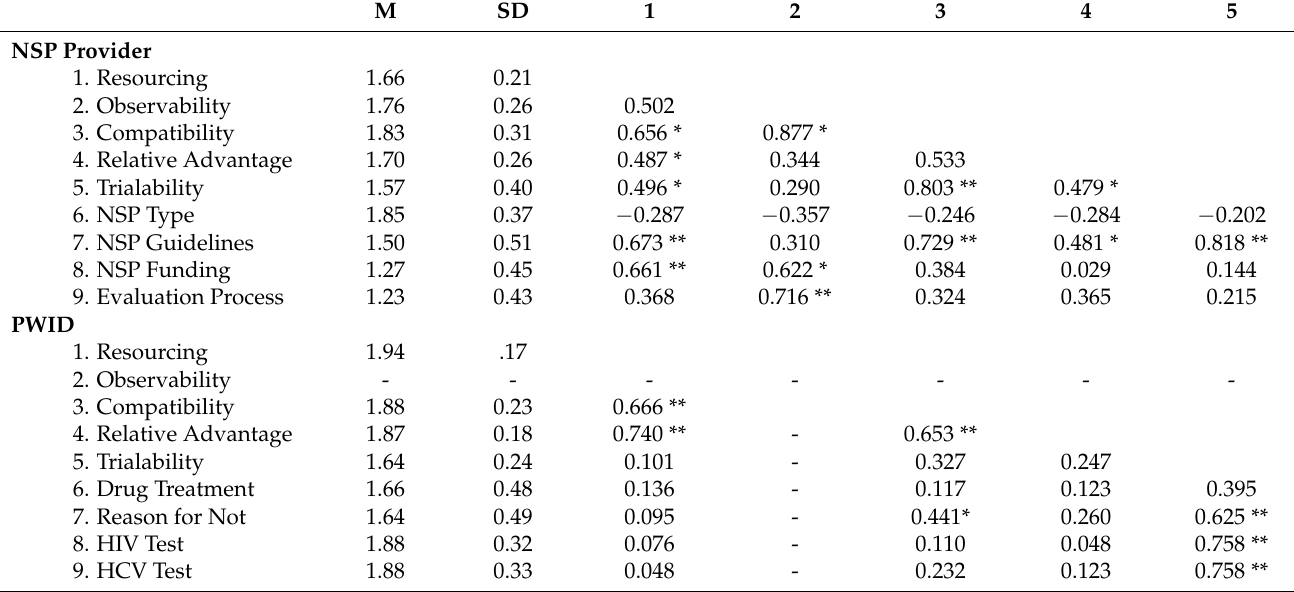
Table 2. NSP Provider and PWID Implementation Quality Correlations.